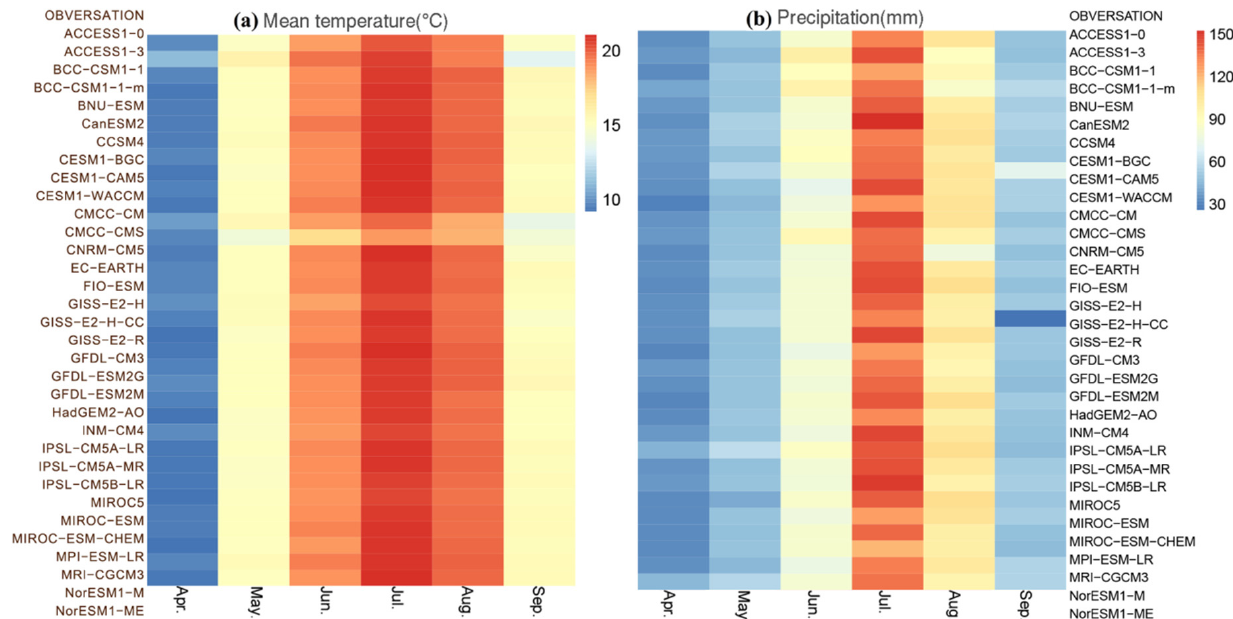
Figure 4. Heat maps of the temperature and precipitation of midwestern Jilin Province between the observations and simulation results for 1980–2020.